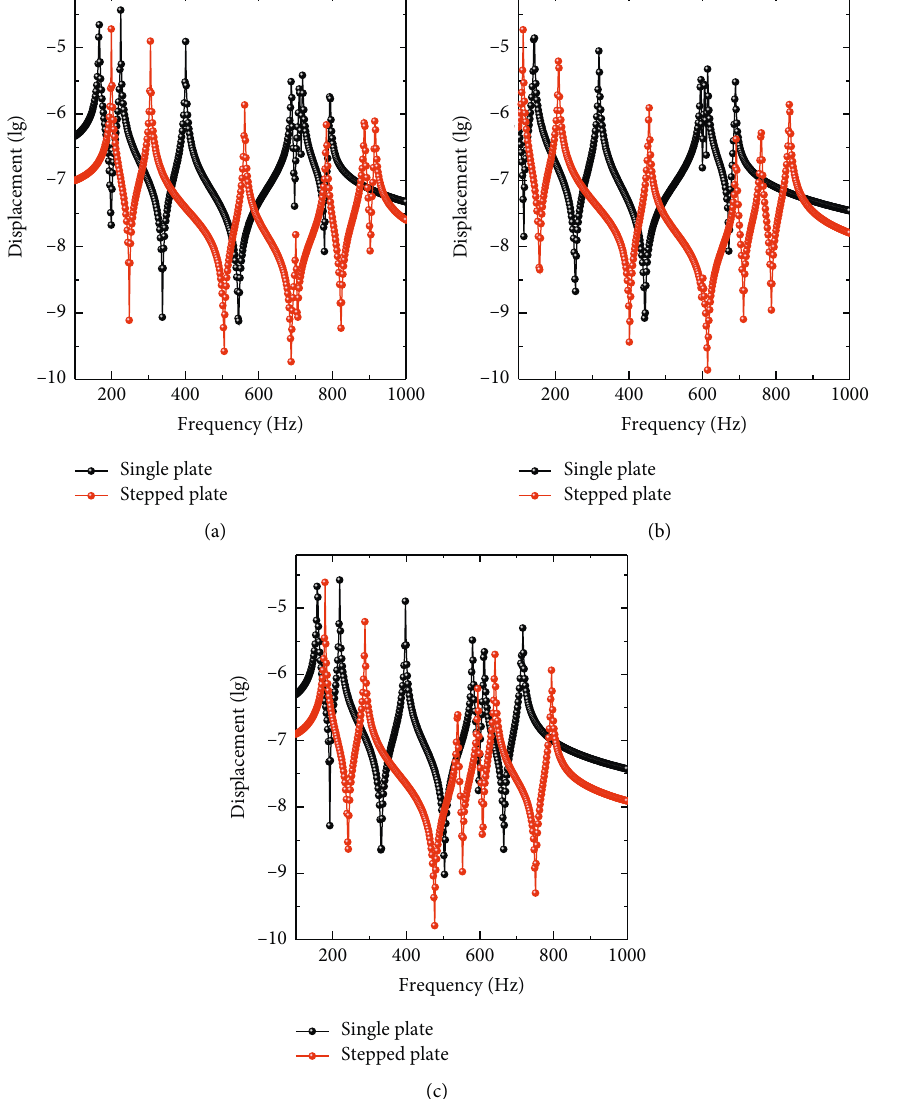
Figure 15: The frequency-displacement characteristics of non-stepped and multi-stepped FG-CNTRC plates. (a) CCCC. (b) SSSS. (c) E 1 E 1 CC.